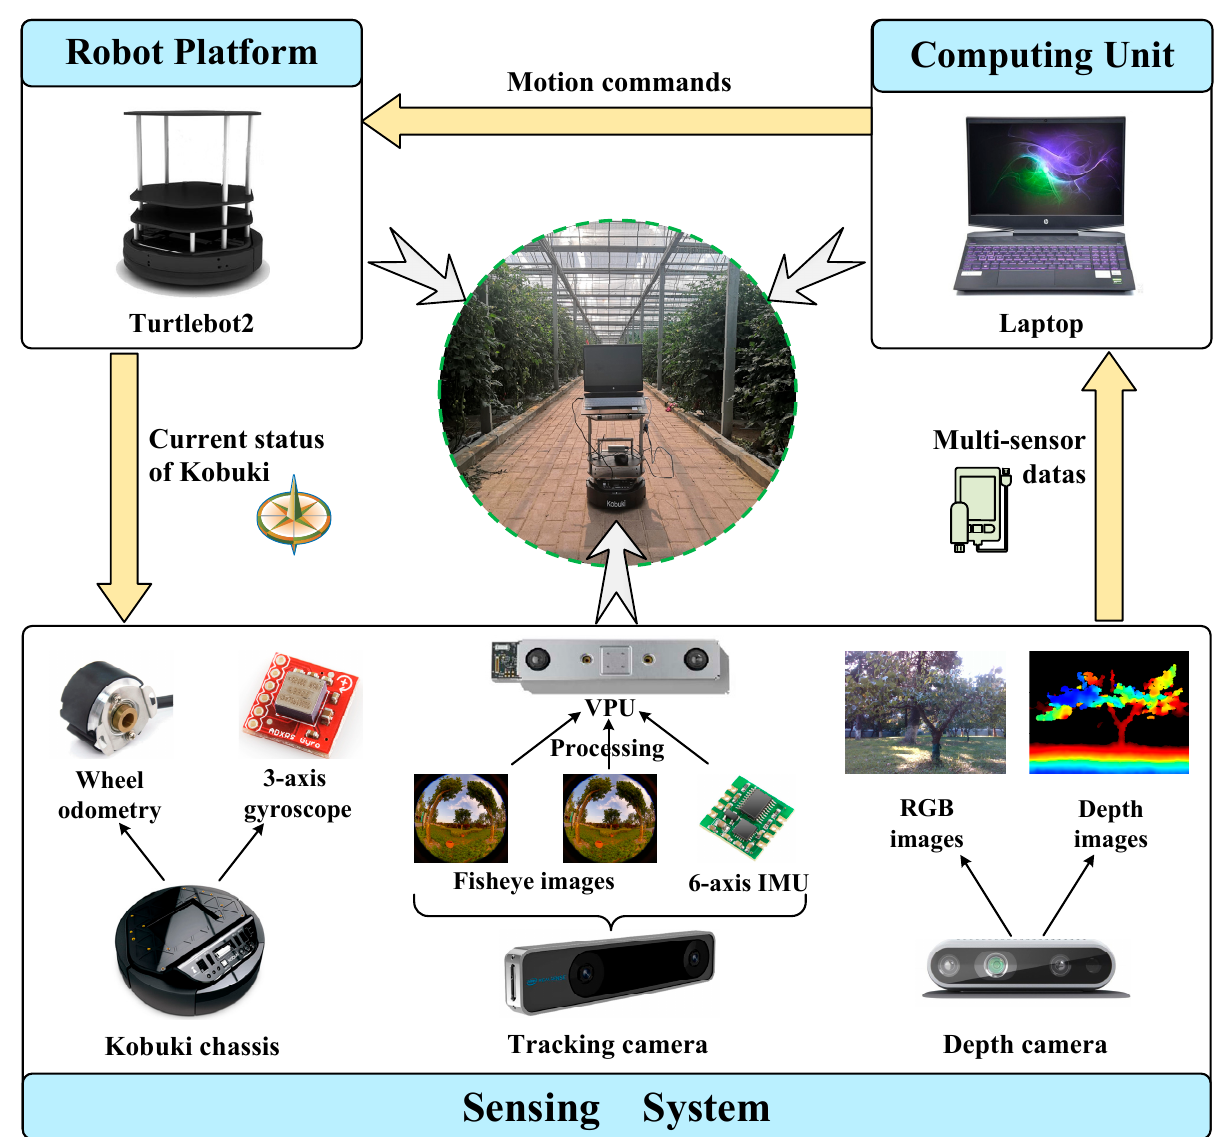
Figure 1. The hardware platform of the proposed real-time localization and mapping system.